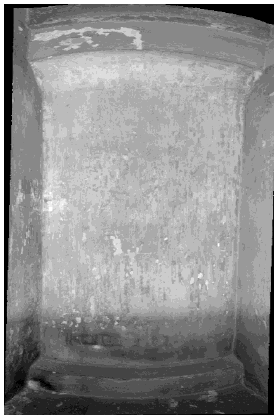
Figure 10. 2D intensity image generated of wall